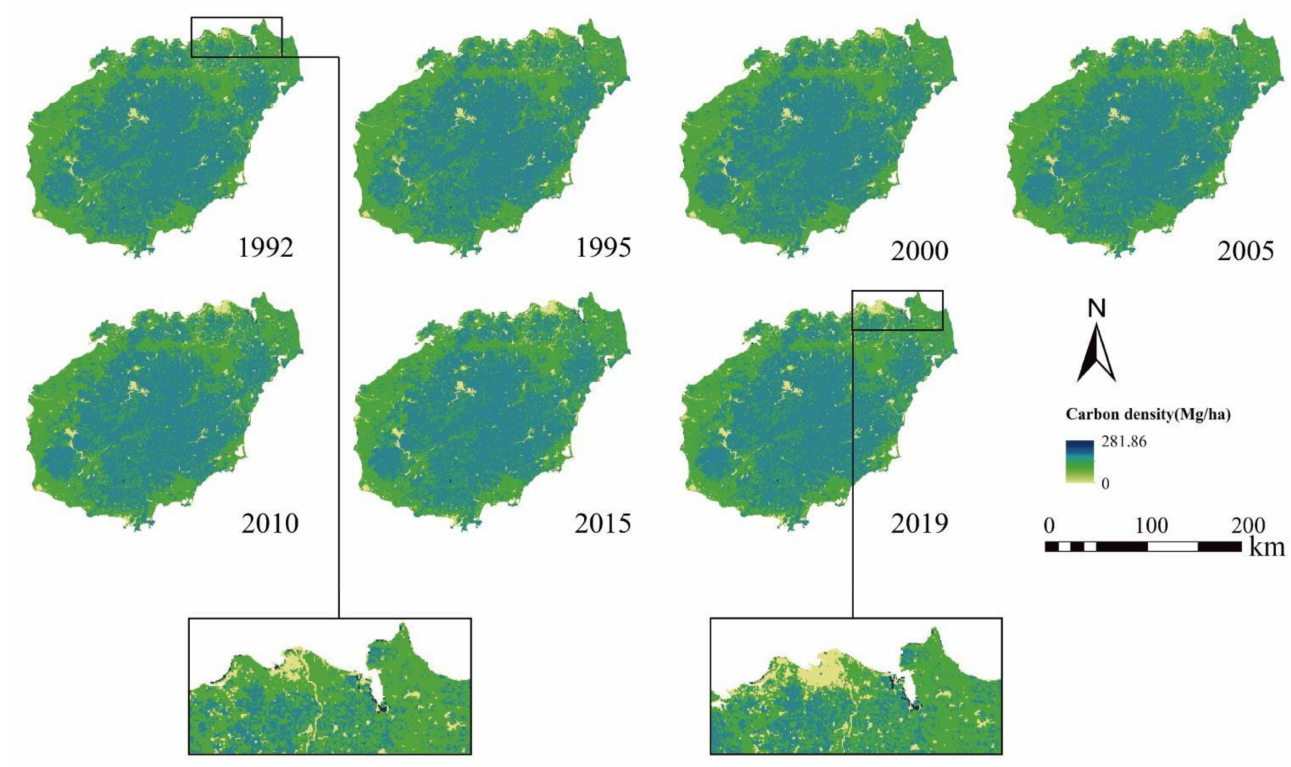
Figure 7. Carbon storage distribution dynamics of Hainan Island from 1992 to